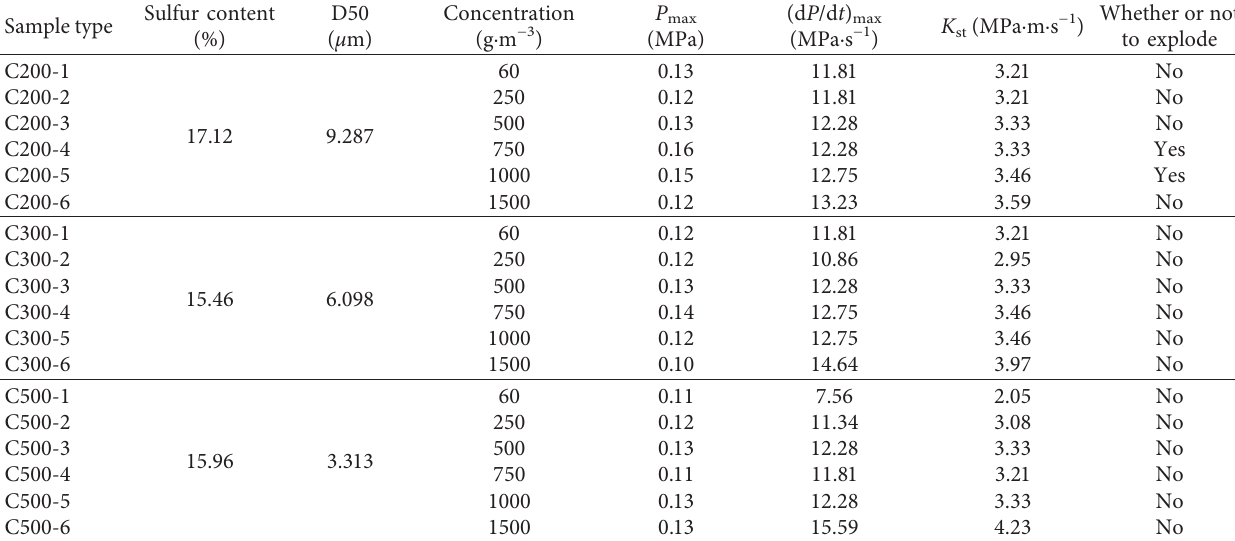
Table 6: Summary of explosion pressure data for C